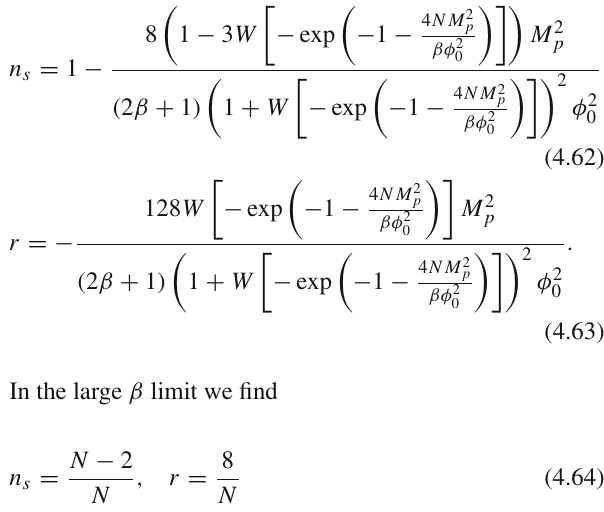
Fig. 8 n s vs r for φ 0 in the interval 10 − 4 M p ≤ φ 0 ≤ 10 − 3 M p for N = 50 , 60 , 70 and β = 10 10 . All curves pass through zones of the region favored by